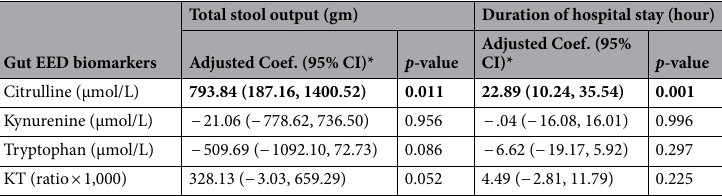
Table 6. Association of citrulline, kynurenine, and tryptophan concentrations and the KT ratio at baseline with diarrhea outcome. Coef.: coefficient; 95% CI: 95% confidence interval; Separate models adjusted for age at enrollment. Values represent the beta coefficient and 95% CI from linear regression models.